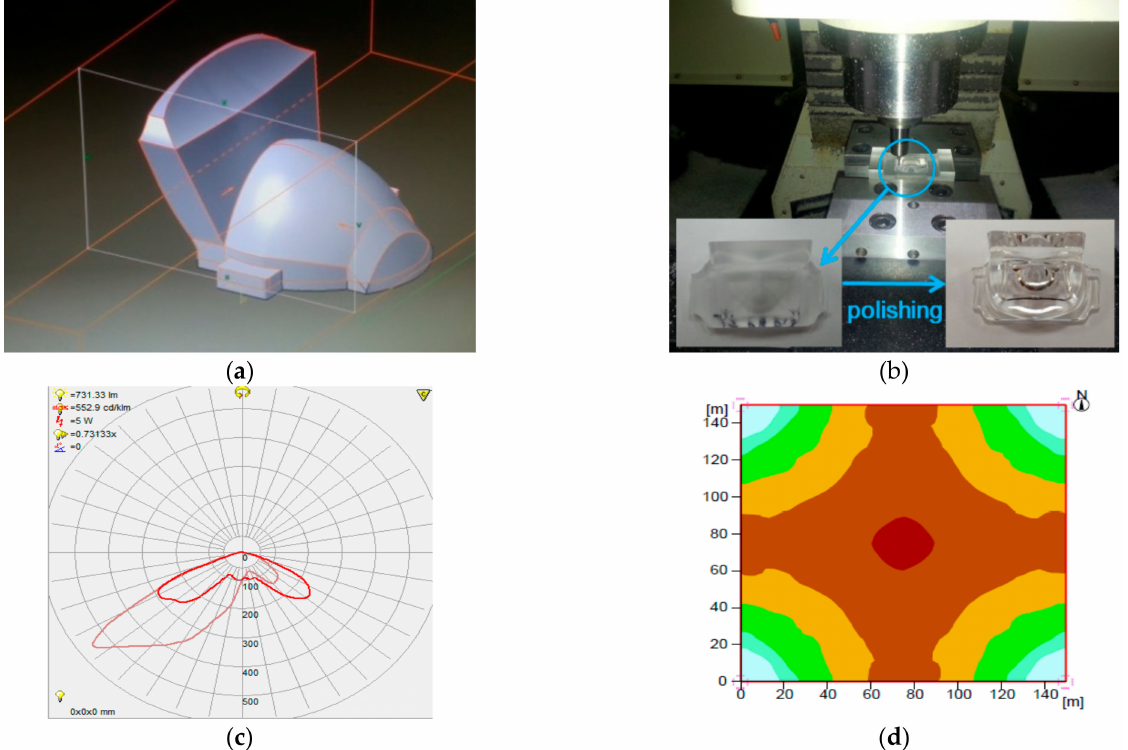
Figure 2. Optical lens design using LightTools software ( a ), fabricated optical lens using high-speed precision processing machine ( b ), measured actual light distribution of LED PKG with an optical lens ( c ), and simulated light distribution considering a real dimension (150 m × 150 m) of seaport installation ( d